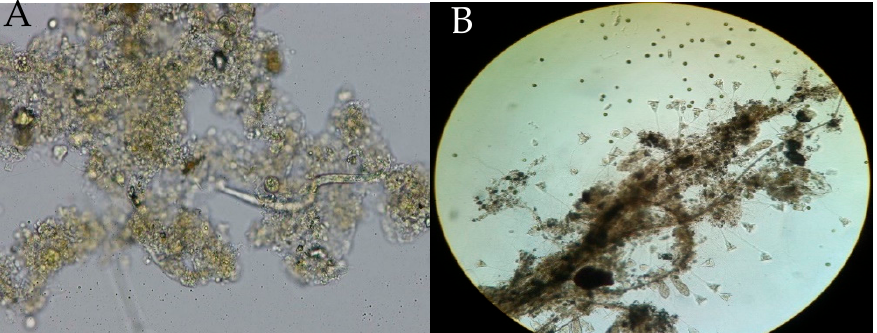
Figure 2. ( A ) Biofloc with Nematoda ; ( B ) Biofloc with Vorticella and Chlorella. Source: Photographs provided by David Celdrán Sabater (2020).